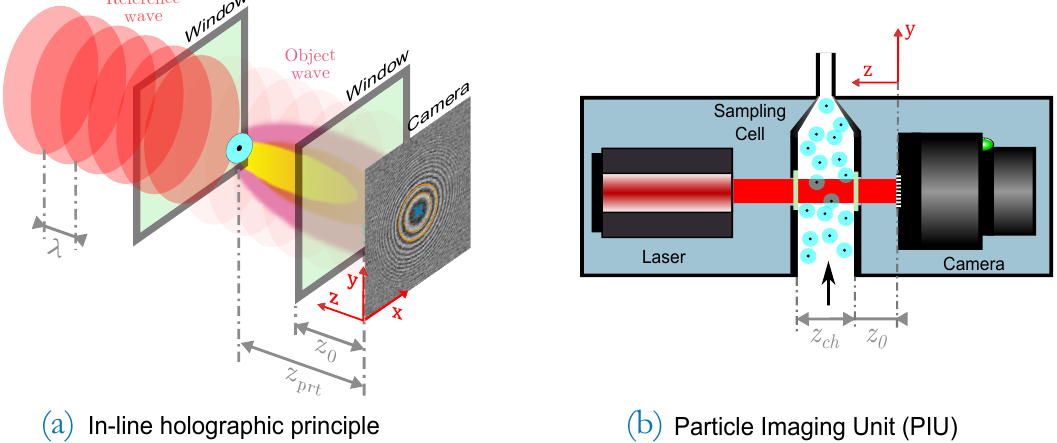
Figure 1. ( a ) in-line holographic principle where a single particle creates a fringe pattern at the camera plane (particles are single neclei in droplets); ( b ) schematic of the in-line holographic counting unit, subsequently called Particle Imaging Unit (PIU) cf.